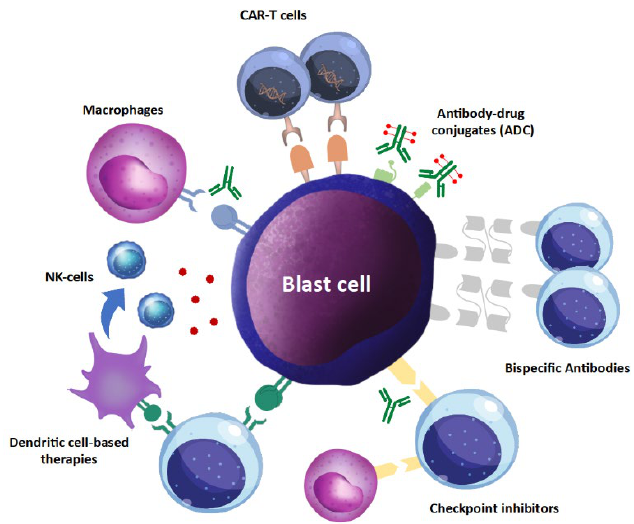
Figure 2. Overview of the immune-based therapeutic approaches under investigation. Starting from the top right and going clockwise: ADC are monoclonal antibodies against a specific tumor antigen, linked to a drug/toxin which is internalized in the target cell, causing its death. Bispecific antibodies have two targets, one specific for the tumor cell and the other for T cells, and function as T-cell engagers. Checkpoint inhibitors enhance anti-leukemic immune responses by the inhibition of the suppressive effect of checkpoint proteins. Dendritic cell-based therapies consist of vaccination strategies either with peptides or directly with DCs loaded with tumor antigens which are then presented on their surface to both T and NK cells. A macrophage-based therapy is represented by magrolimab, an anti-CD47 monoclonal antibody that interferes with the suppressive signals for macrophages, working similarly to checkpoint inhibitors. Finally, there are cellular therapies with adoptive NK cell infusions or CAR-T cells. Chimeric antigen receptors are surface molecules with an antigen-recognition domain linked to signaling regions of the T-cell receptor pathway, capable of T-cell activation.